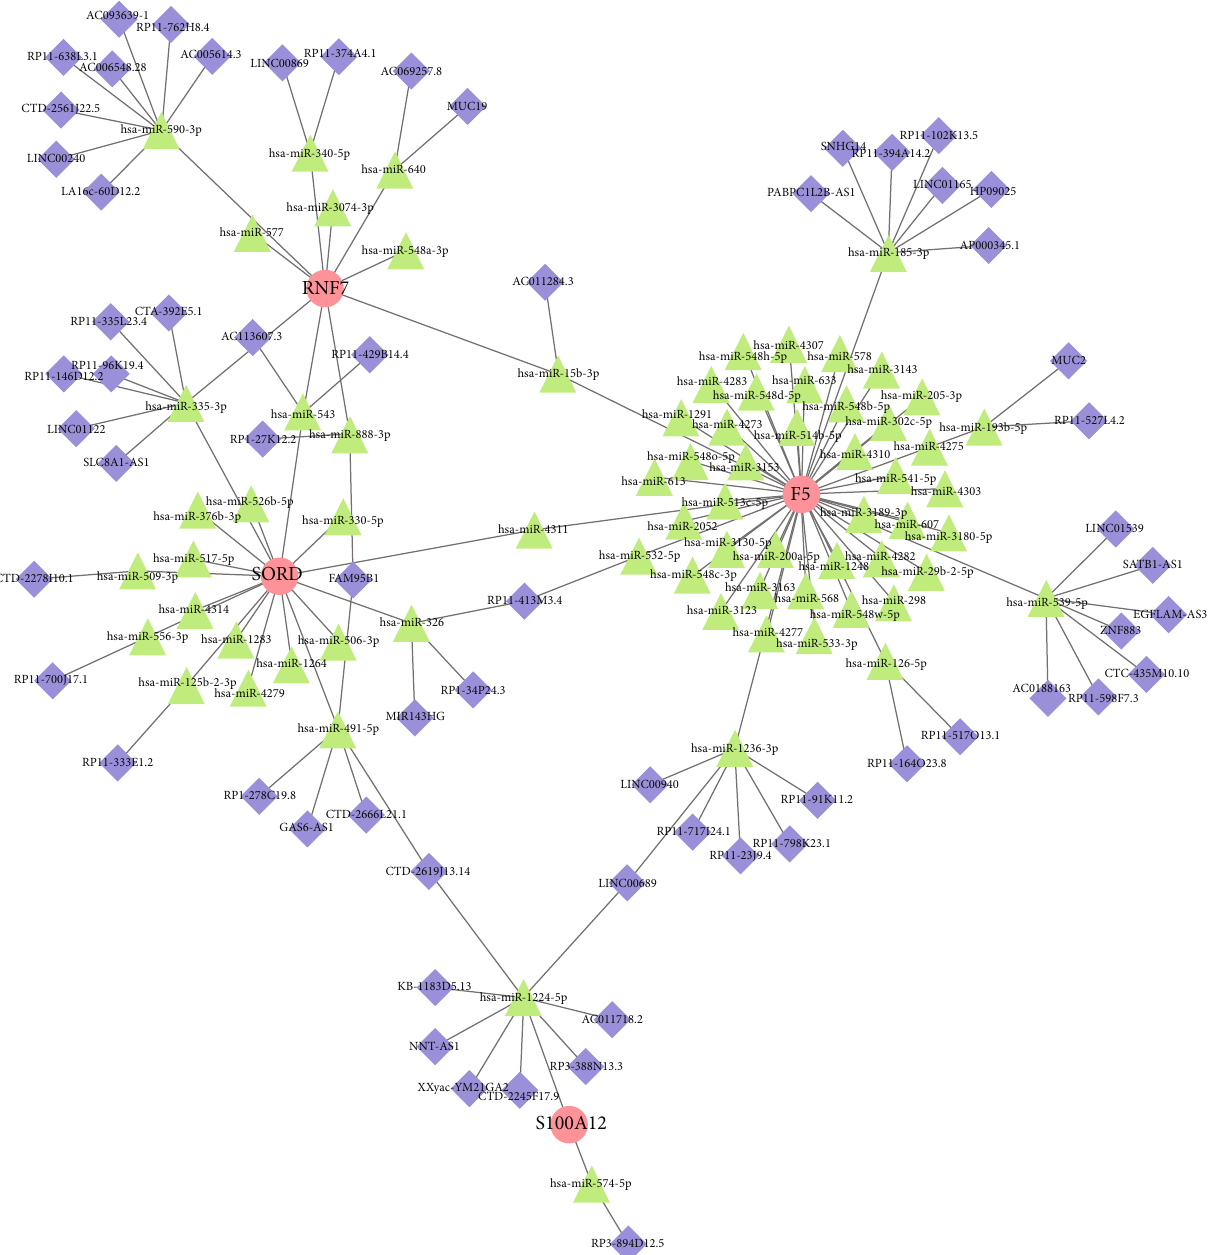
Figure 6: Established a lncRNA-miRNA-mRNA ceRNA network based on marker genes. The complex network included 139 nodes (64 lncRNAs, 71 miRNAs, and 4 marker genes) and 143 edges. Blue diamond represents lncRNAs, green triangle represents miRNAs, and red ellipse represents